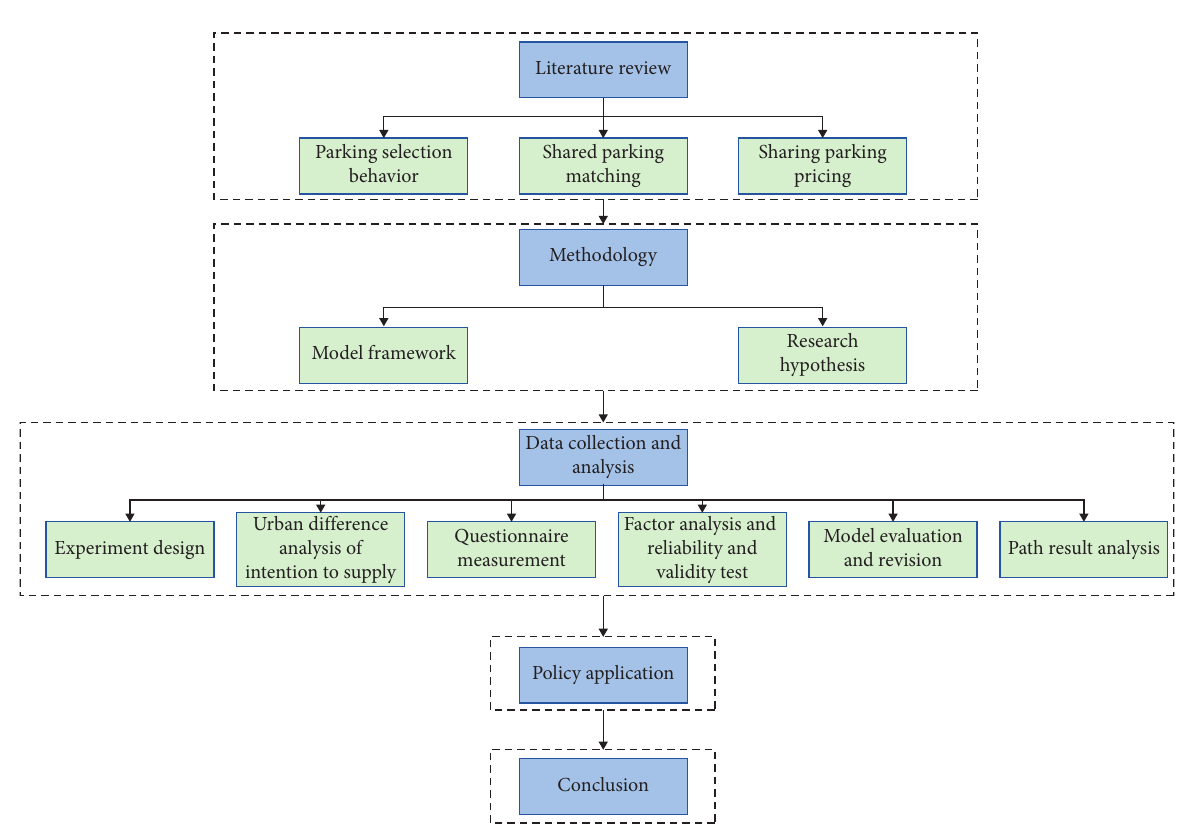
Figure 2: The framework of this study.